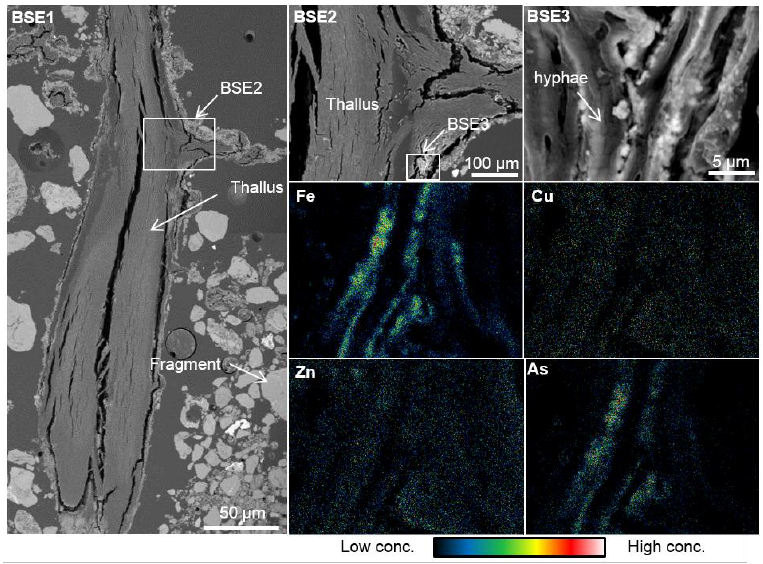
Figure 6. Back-scattered electron images and the elemental maps of hyphae inside the cortex of the thallus. The white box in BSE2 indicates the area of BSE3 and the mapping analysis area.